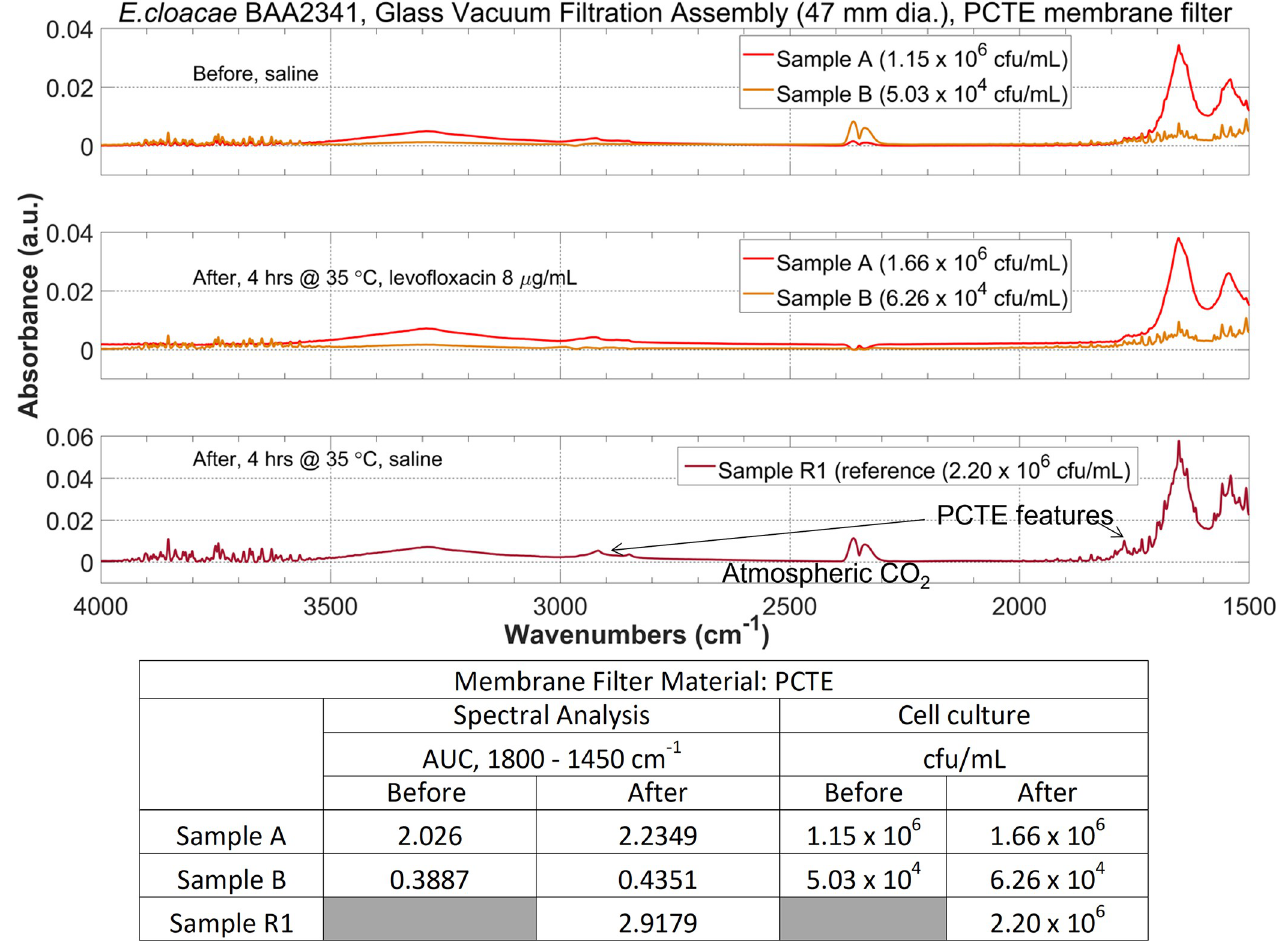
Fig 5. Antimicrobial-induced bacterial spectral changes at 10 6 and 10 4 cfu/mL can be detected for a levofloxacin-resistant E . cloacae BAA2341 samples before and after incubation with 8 μ g/mL levofloxacin for 4 hours at 35˚C. A sample of bacteria incubated in saline under the same temperature for the same duration was prepared as positive control and ATR spectra were acquired. The bacteria peak intensities in the before and after incubation spectra as well as from the positive control spectrum did not vary significantly, which were confirmed by the cell culture results and matches with the levofloxacin-resistance nature of this bacteria